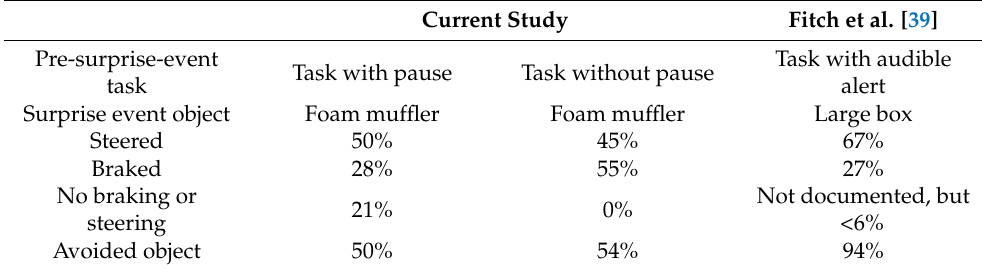
Table 2. Comparison of surprise event scenarios. Current Study Fitch et al.